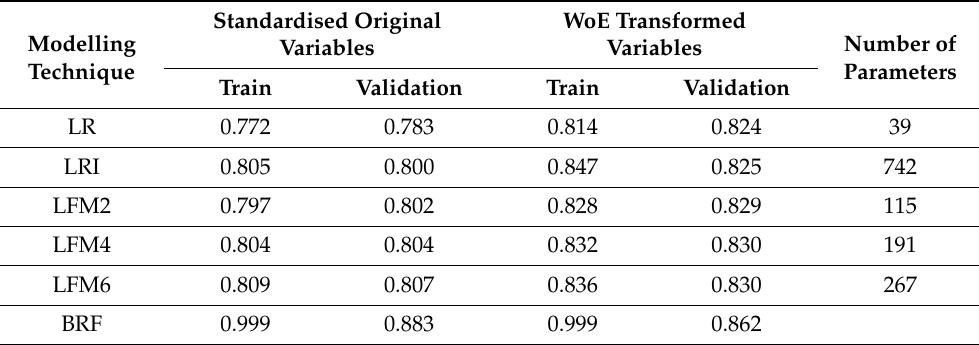
Table 16. Ginis obtained by the models for the credit scoring data